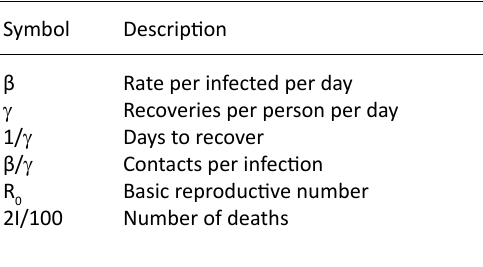
Table 1. Symbol description for Generalized SIR